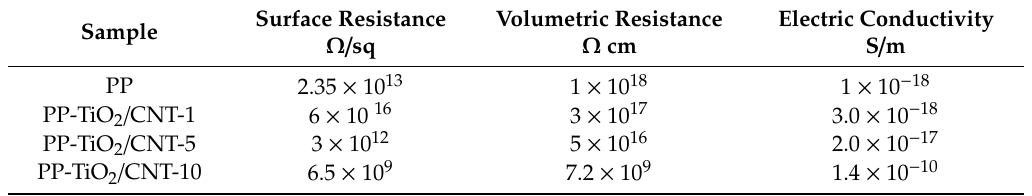
Table 5. Electrical properties of polypropylene (PP) and PP-TiO 2 / CNT (carbon-nanotubes) nanocomposites.